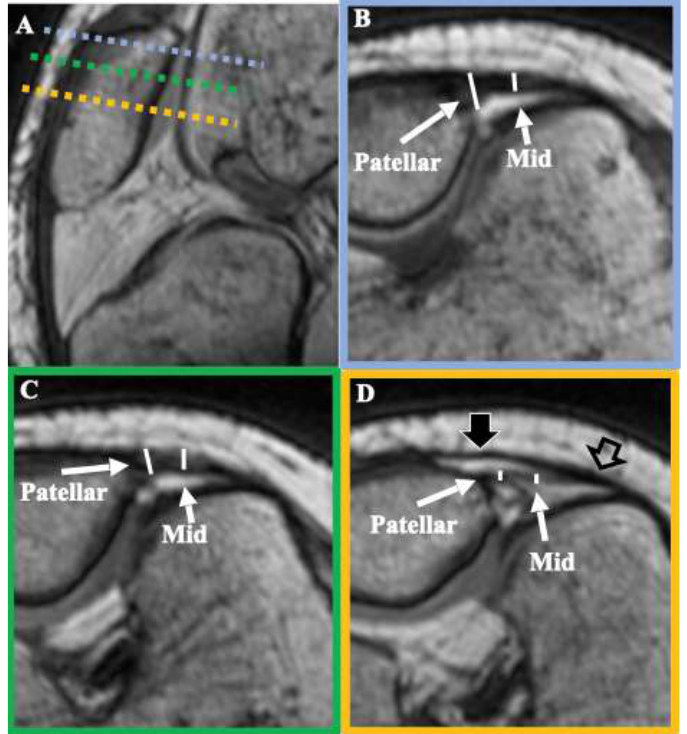
Figure 2. T1 3D VIBE images of a cadaveric knee demonstrating MPFL thickness measurements. Image ( A ) demonstrates the oblique axial planes where MPFL thickness measurements are collected, where dashed colored lines represent the oblique axial plane indicated by the respective frame color of images ( B – D ). Thickness measurements at the patellar attachment and the middle (Mid) of the MPFL are presented with white lines on a proximal ( B ), middle ( C ), and distal ( D ) point of the ligament. Distally, the surface layer of the joint capsule (thick black arrow) can be differentiated from the deep layer of the MPFL. However, it is evident that the capsule merges with the MPFL at the femoral attachment site (thick empty arrow), rendering unreliable the measurement of the exact MPFL femoral insertion area and thickness close to the femur.